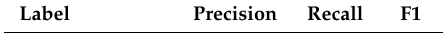
Table 8. ASSIN2 NLI results per class, for the fine tuned ptBERT-Large model.